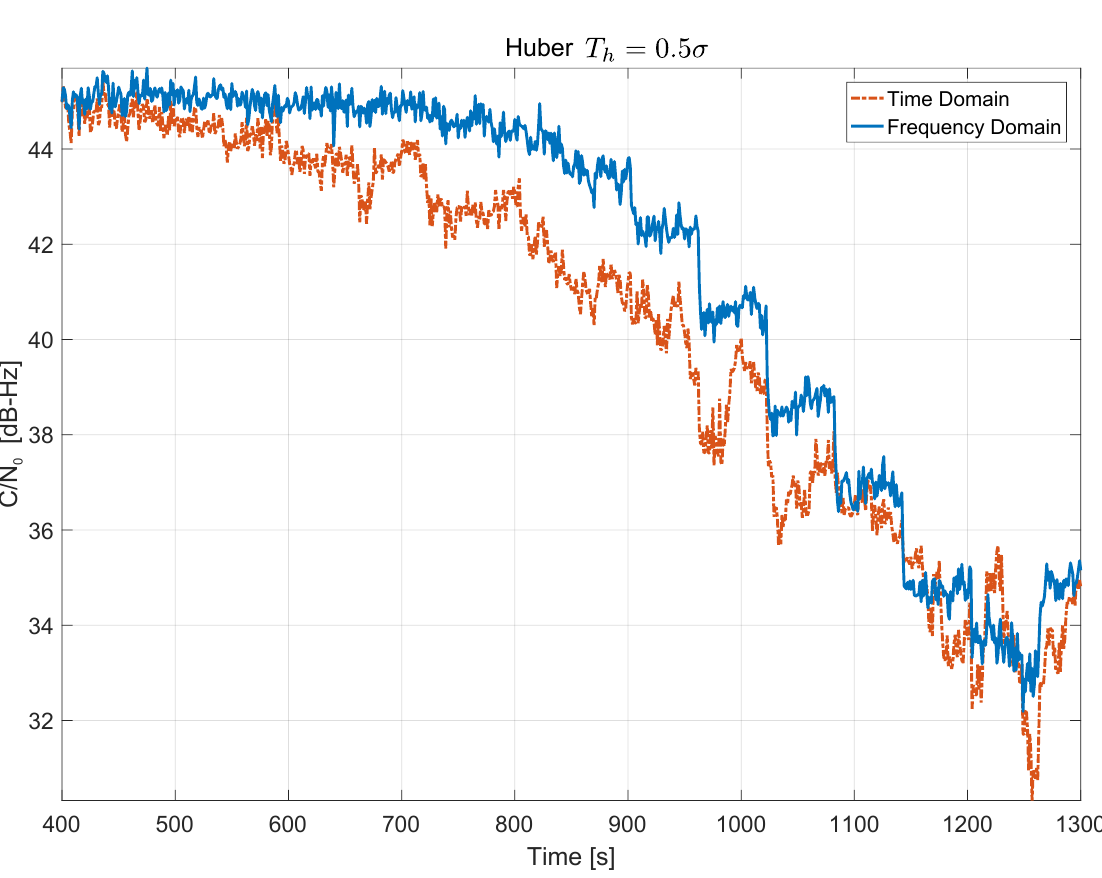
Figure 11. Comparison between C / N 0 time series obtained using time domain and frequency domain processing. Anechoic chamber test with GPS signals. In both cases, Huber’s non-linearity with T h = 0.5 σ was